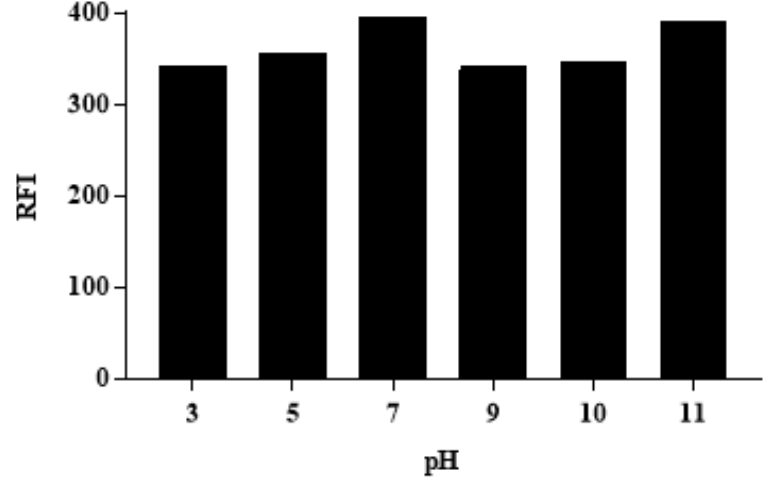
− 1 ) in a Cr RH 40 (1%, w / v )